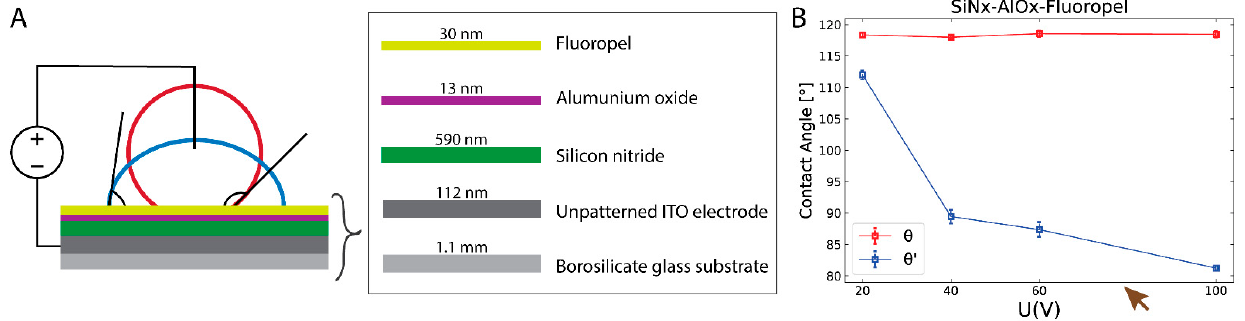
Figure 2. Evaluation of the electrowetting on dielectric (EWOD) phenomenon on a microfluidic platform comprising a multilayer dielectric hydrophobized with Fluoropel upon the application of voltage. ( A ) A schematic representation of the change of the static contact angle (SCA) of the unpotentiated aqueous droplet (red line) in response to the applied electric field (blue line). The bottom substrate with deposited insulating and hydrophobic coatings is shown. ( B ) Initial ( θ , no voltage applied) and potentiated SCAs ( θ (cid:48) , after the application of DC voltages ranging from 20 V to 100 V) of 5 µ L PBS droplet are presented. The brown arrow indicates a measurement point at which electrolysis occurred upon the application of 80 V on one of the samples (1/3). Reproduced in part with permission from the Chemical and Biological Microsystems Society (CBMS).